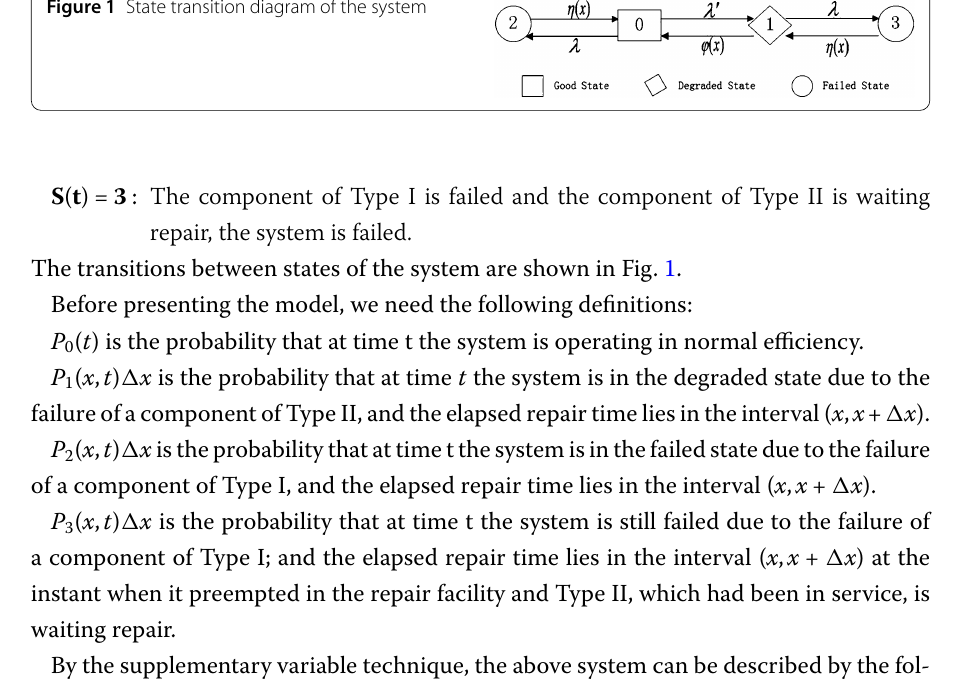
Figure 1 State transition diagram of the